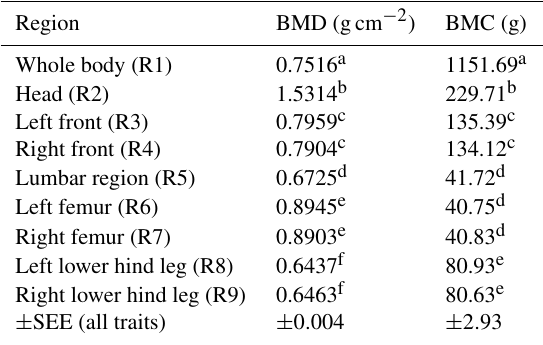
Table 3. BMD and BMC depending on body region (LSM ± SEE, standard error of estimation). Different superscripts represent sig- nificant ( p< 0 . 05) differences within